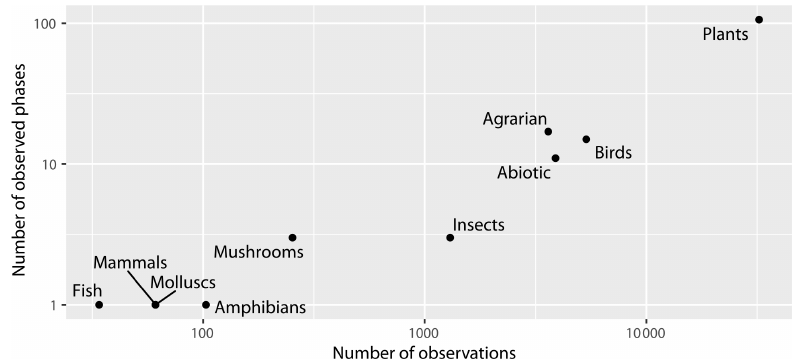
Figure 6. Number of observed phases and observations across taxonomic groups; note that both axes are on the logarithmic scale.